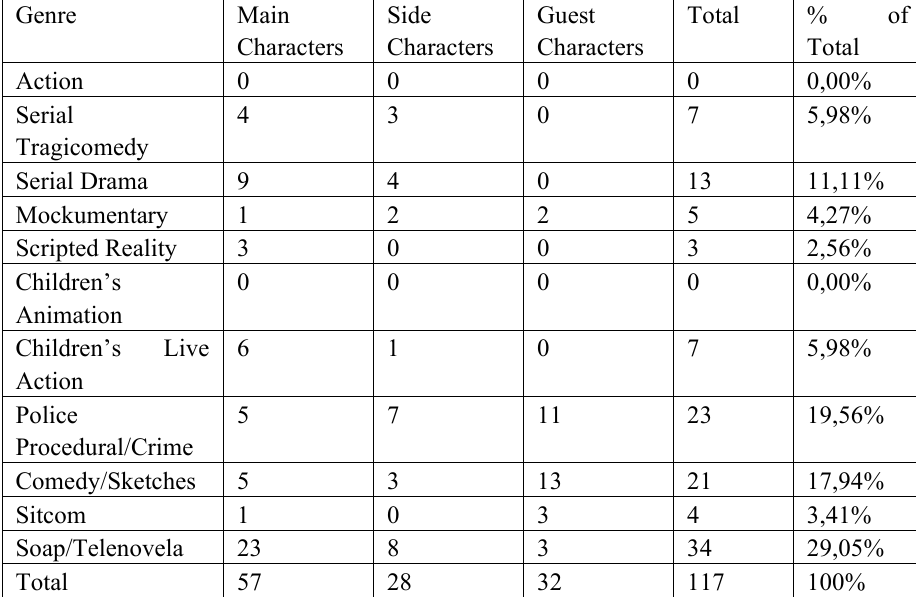
Table 3. LGBT+ character types in domestic television fiction genres (2001 – 2016)